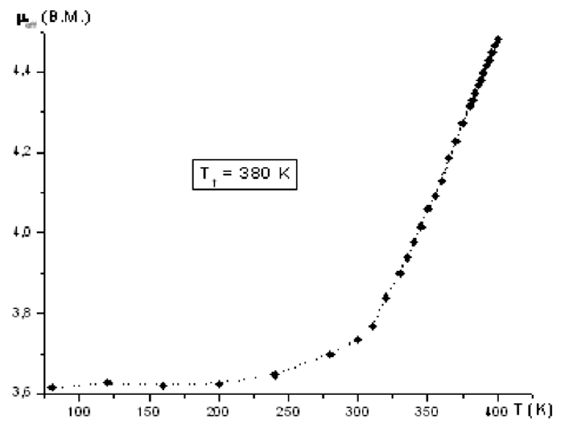
Figure 8. µ e ff ( Т ) curve of [Fe(HC(pz) 3 ) 2 ][Fe(HC(pz) 3 )(NCS) 3 ]NCS. Figure 8. μ eff ( Т ) curve of [Fe(HC(pz) 3 ) 2 ][Fe(HC(pz) 3 )(NCS) 3 ]NCS.